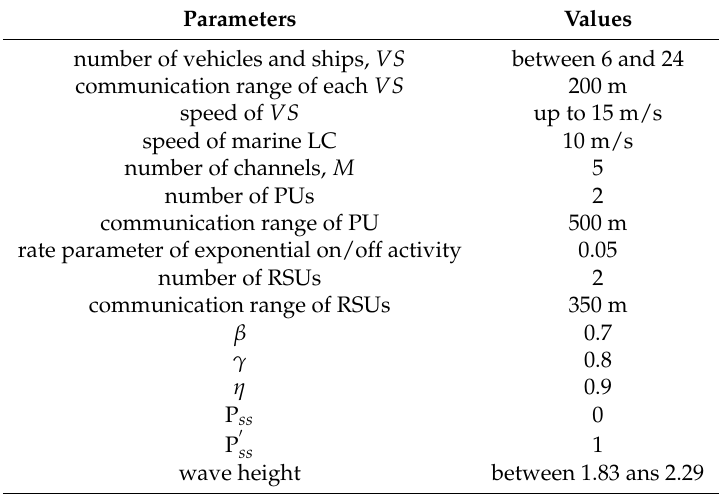
Table 1. Simulation parameters. Parameters